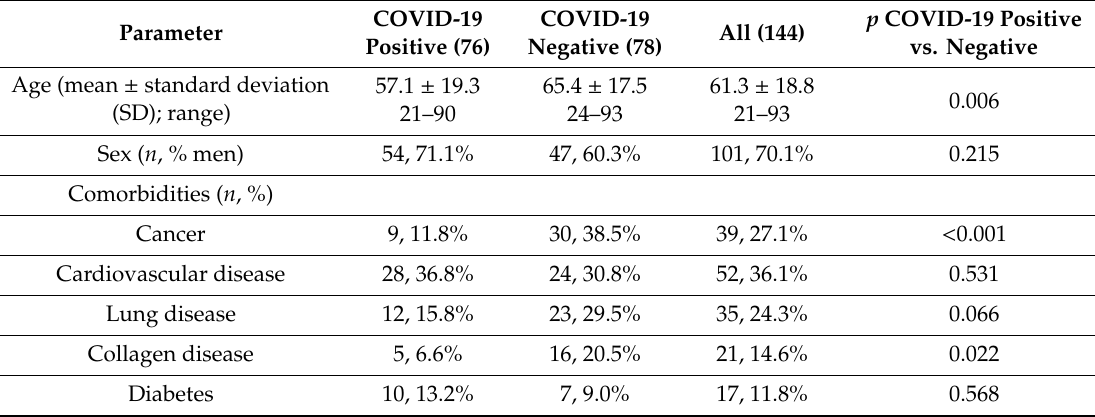
Table 2. Characteristics of